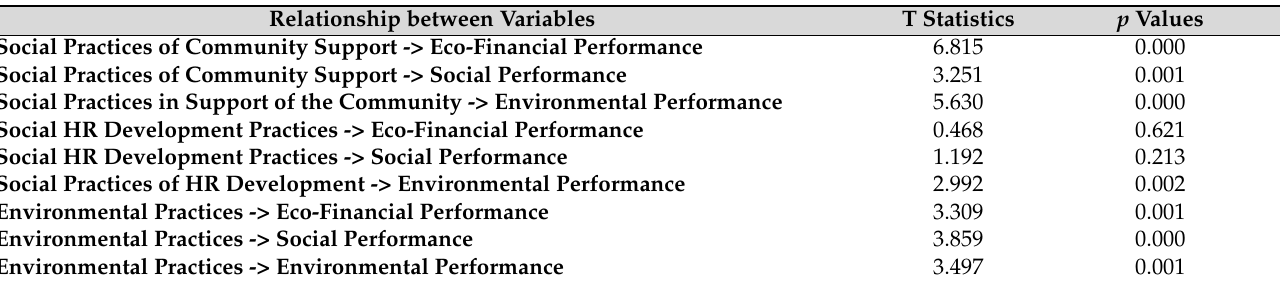
Table 11. Relationship between variables (Student’s t-test).